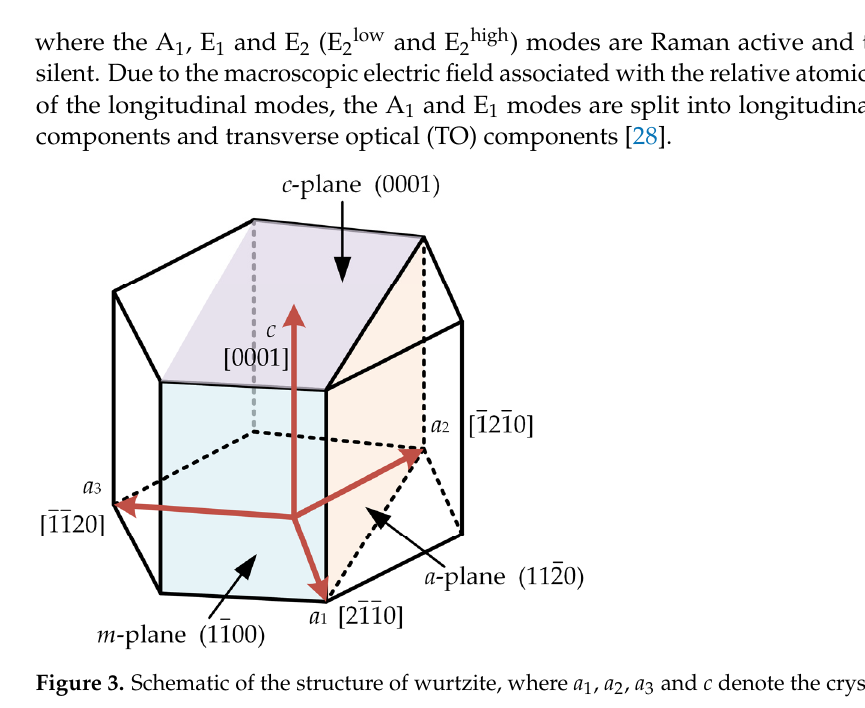
Figure 2. Schematic of the Raman mapping experiment around the indentation on the (0001) plane GaN.